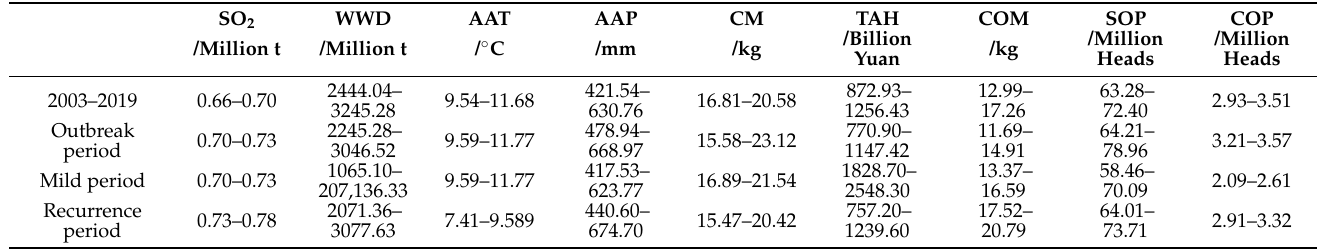
Table 6. Favorable conditions for the spread of